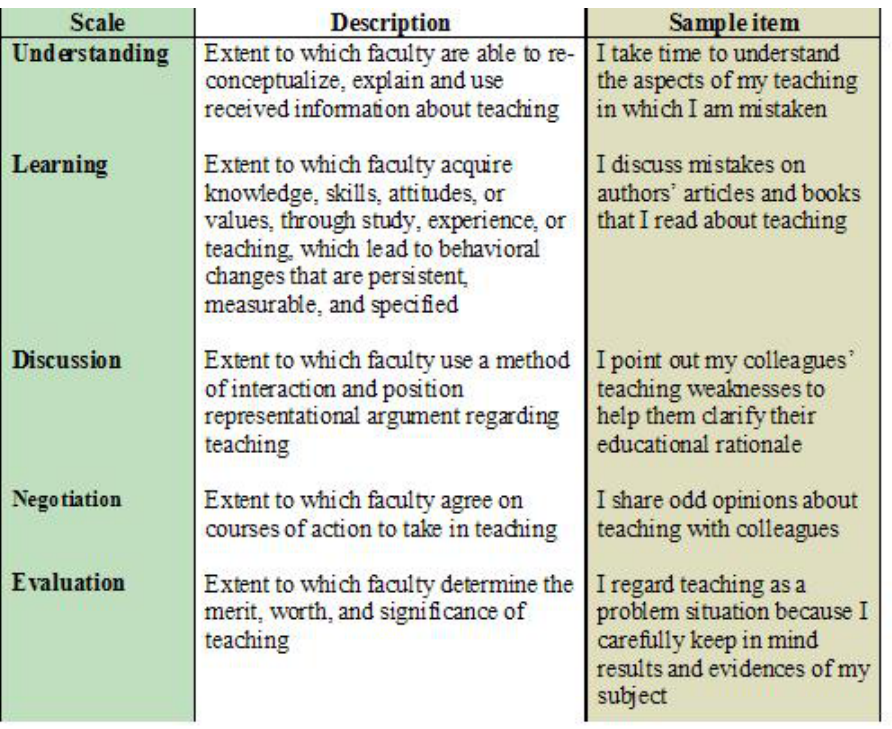
Table 1. Description of Scales and a Sample Item for Each Scale of the